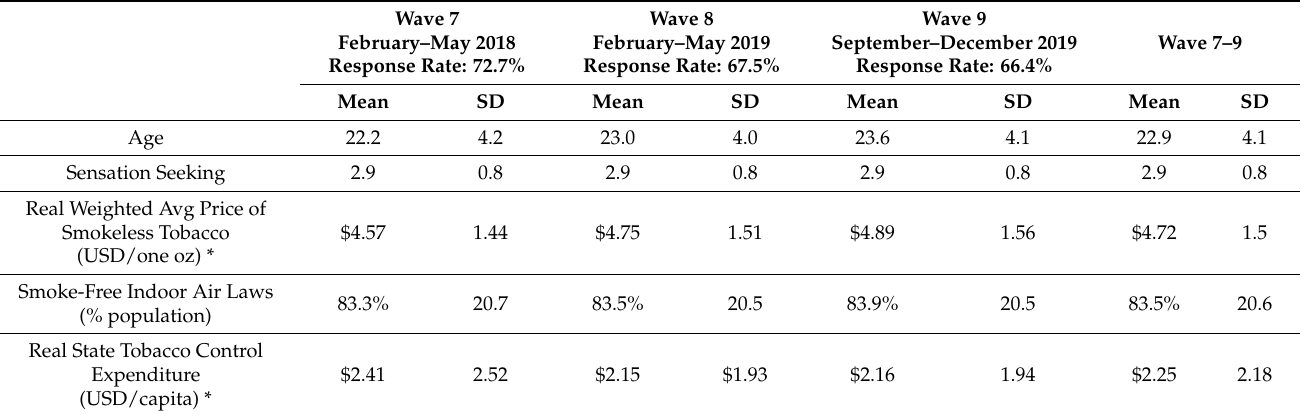
Table 2. Continuous sample characteristics across Waves 7, 8 and 9 of the national Truth Longitudinal